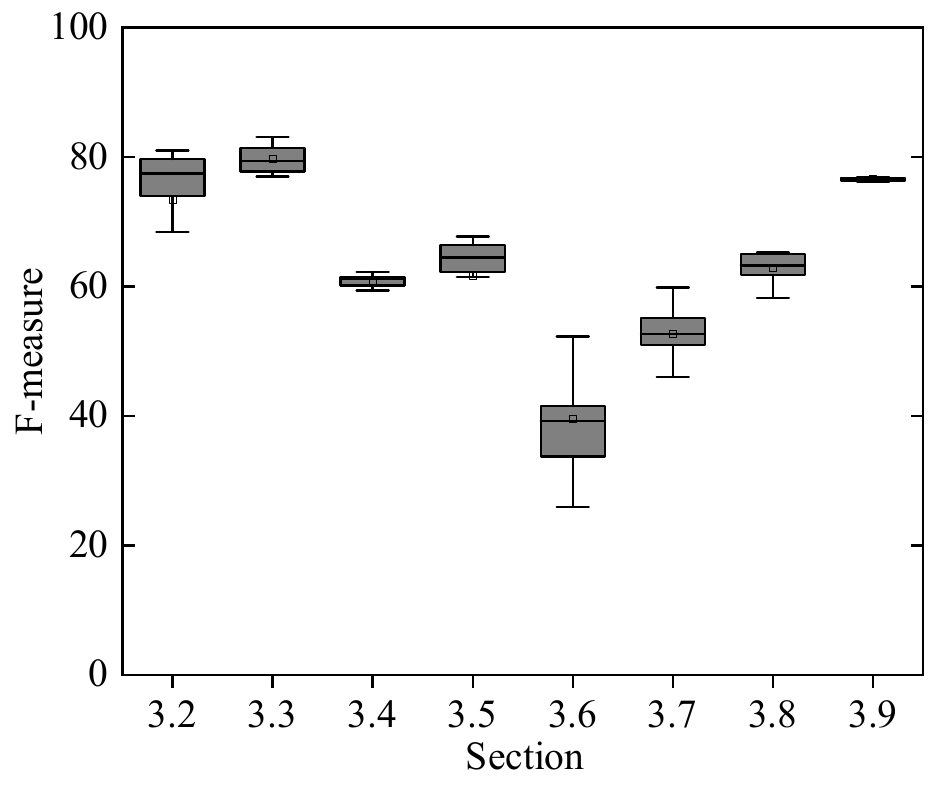
Figure 13. Comparison of F-measures presented in each